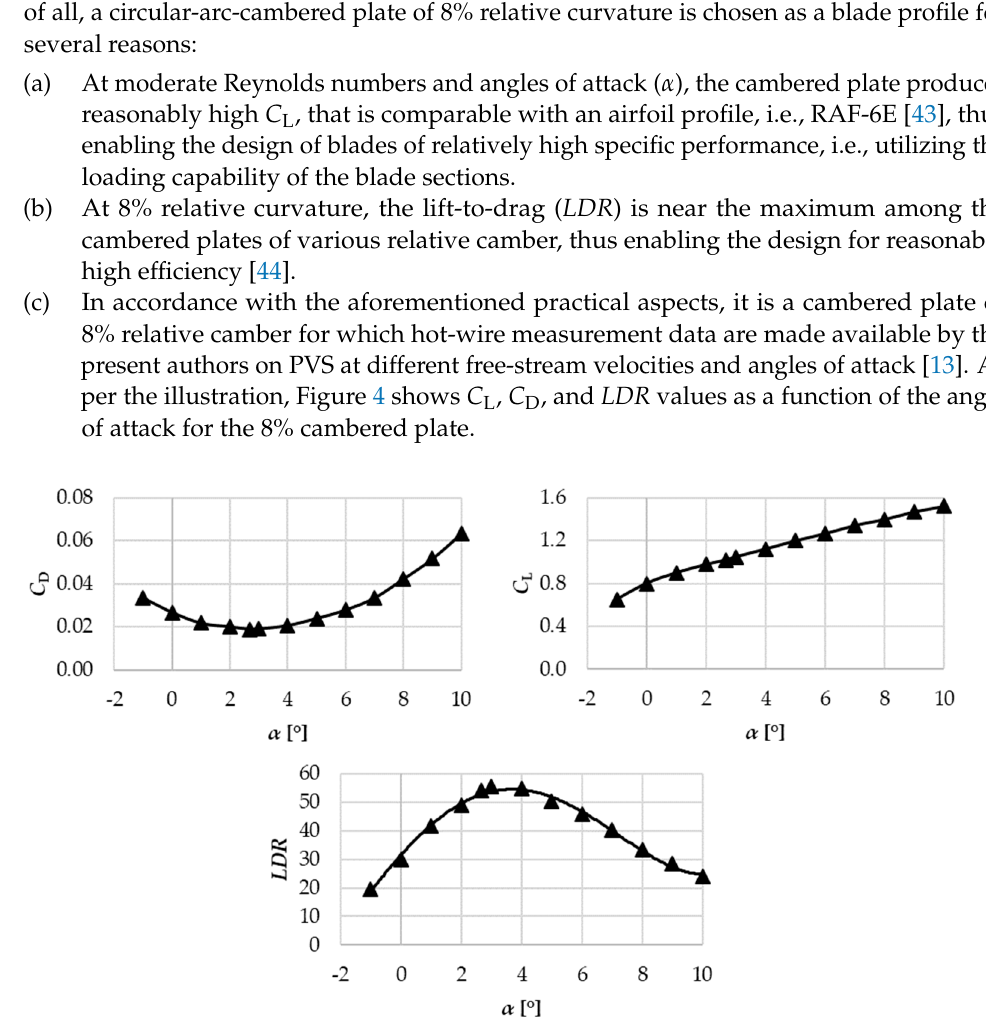
Figure 4. Lift and drag coefficients and lift-to-drag ratios as a function of angle of attack for 8% cambered plate at Re c = 3 × 10 5 measured by Wallis [44].